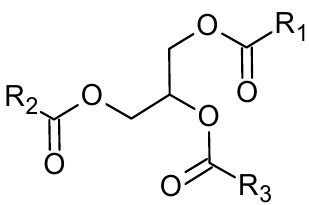
Figure 1. Chemical structure of triacylglycerol. R1, R2, R3 – acyl moieties.